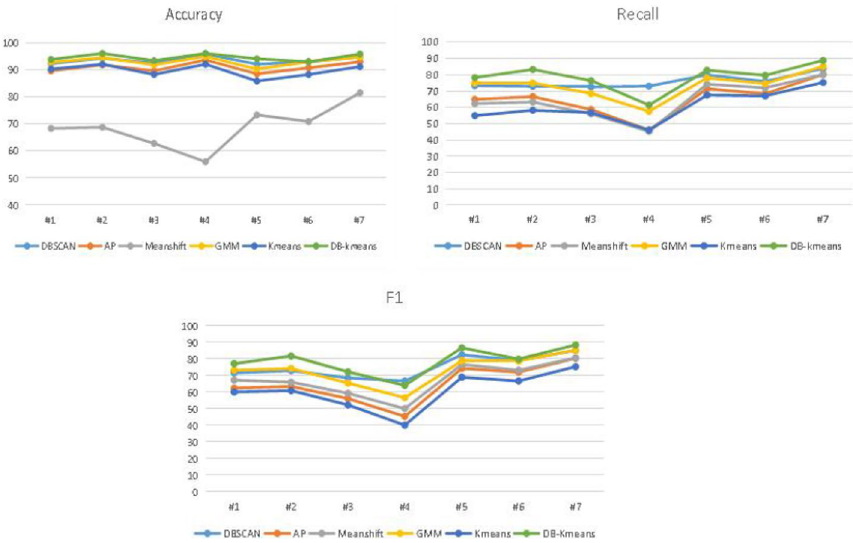
Fig. 4 Line chart of